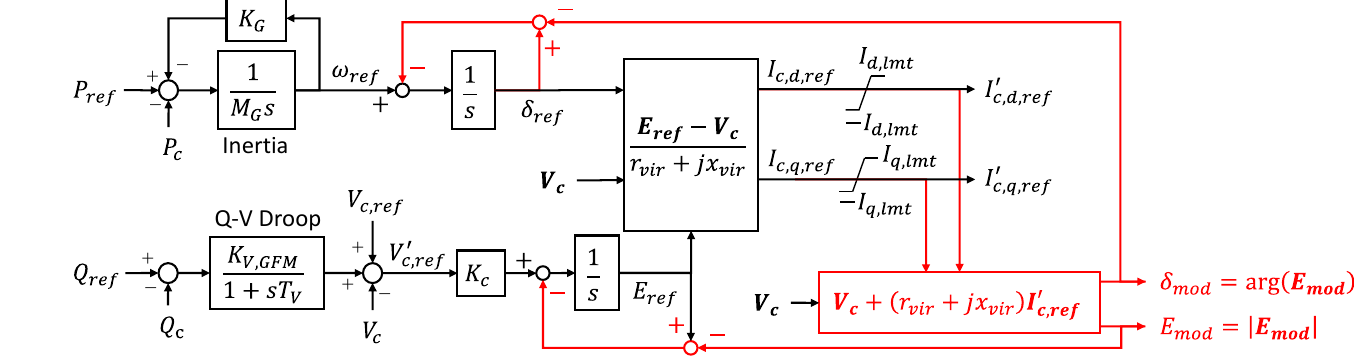
Figure 3. Current limitation with the proposed method modifying internal induced voltage of synchronous generator virtually simulated inside VI-GFM.